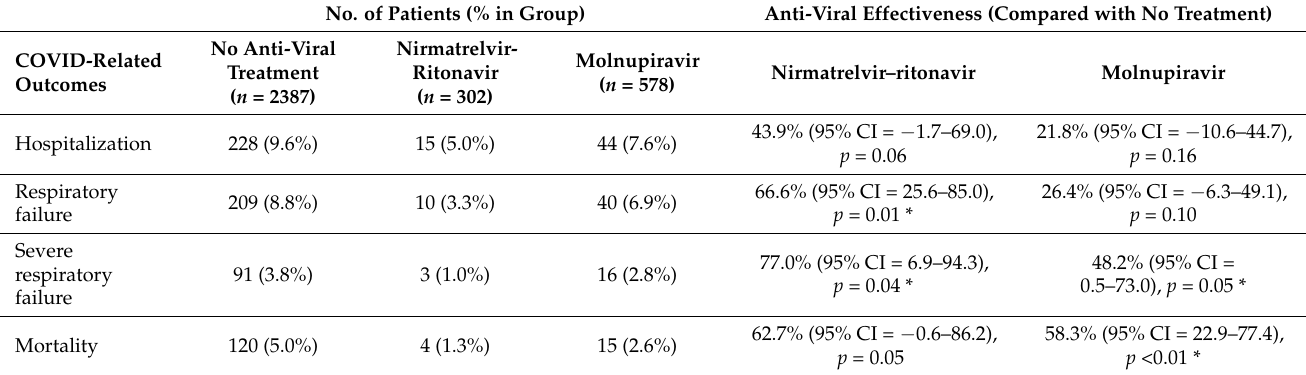
Table 2. Effectiveness of Nirmatrelvir–ritonavir and molnupiravir in preventing COVID-19 related hospitalization, respiratory failure and mortality.